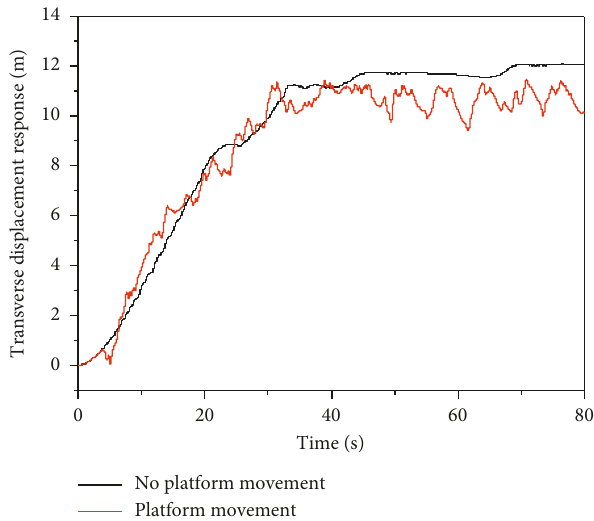
Figure 16: Effect of platform motion on transverse displacement.